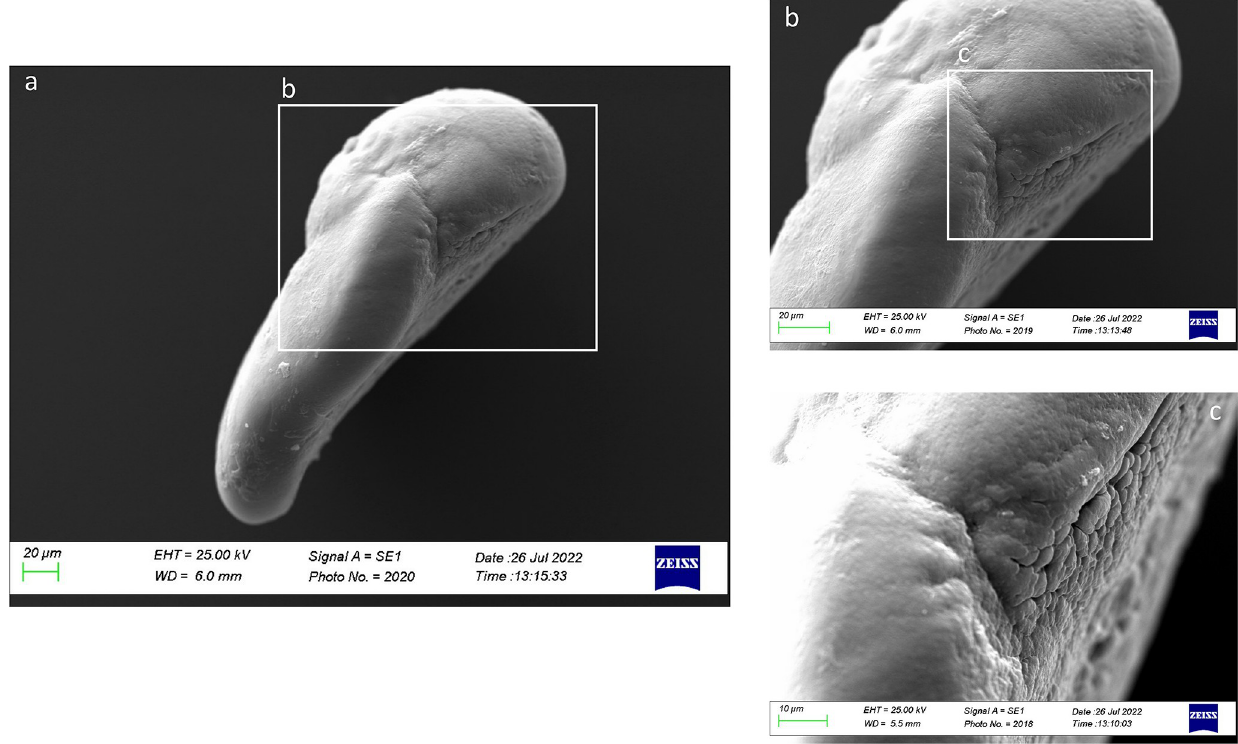
Fig 19. SEM images of a lapillus lateral surface belonging to size Class II (a) with details of gibbus maculae (b) and confluentia gibbi maculae (c) crystalline habits.